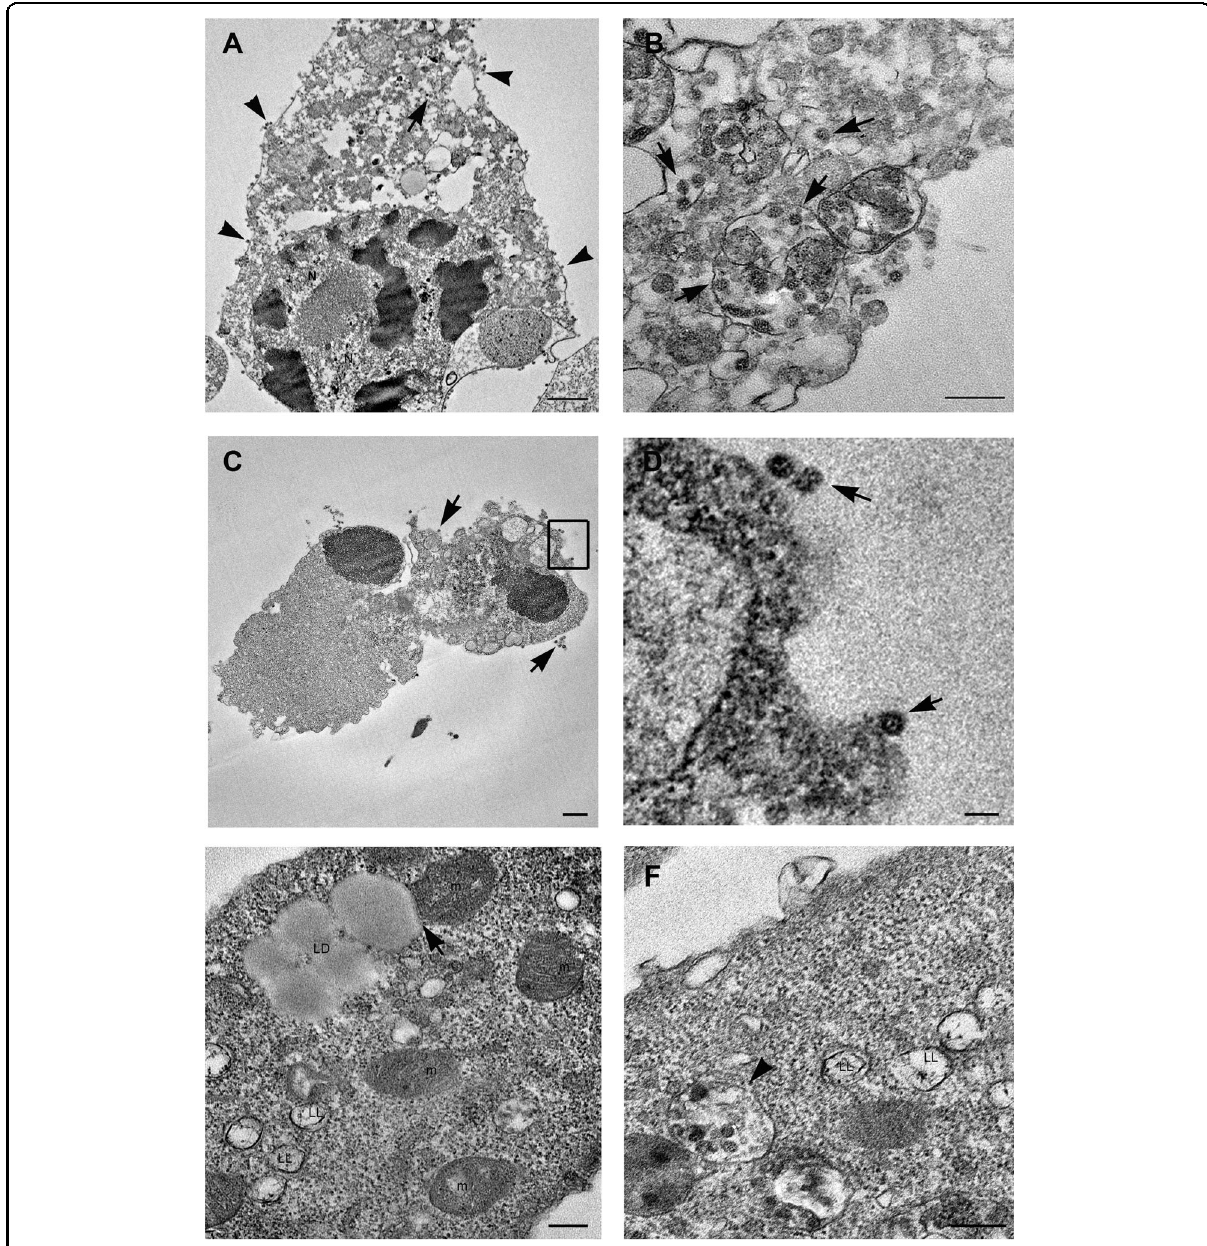
Fig. 2 Electron microscopy features of SARS-CoV-2-infected dying cells. A , B A dying cell shows an advanced stage of degeneration. The nucleus shows condensed areas and the cytoplasm results empty due to the presence of a high number vacuoles, some of which containing viral particles (arrows). Numerous viral particles are also visible at the cell membrane (arrowheads). C Cell remnants showing viral particles outside of cell (arrows). D Higher magni fi cation of the boxed area visible in C shows viral particles (arrows). E Lipid droplets (LD) are present inside infected cells, some of which are in contact with mitochondria (arrow). Lipolysosomes (LL) with external membrane and whorls are detected. Mitochondria (m) show swollen cristae. F Viral particles in structures resembling lipolysosomes (LL) are visible (arrowhead). N nucleus, m mitochondria, LD lipid droplets, LL lipolysosomes. Scale bars: A , C = 1 um; D = 100 nm; B , E , F = 200